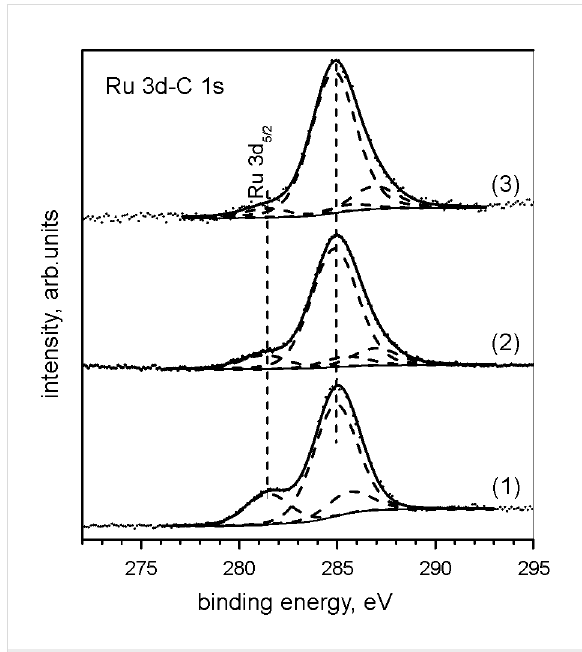
Figure 7: Spectra of the Ru 3d–C 1s photoelectrons for neat com- pound 3 (1), catalyst sample 3 /SBA-15 (2) and catalyst sample 3 /SBA- 15 after leaching in THF